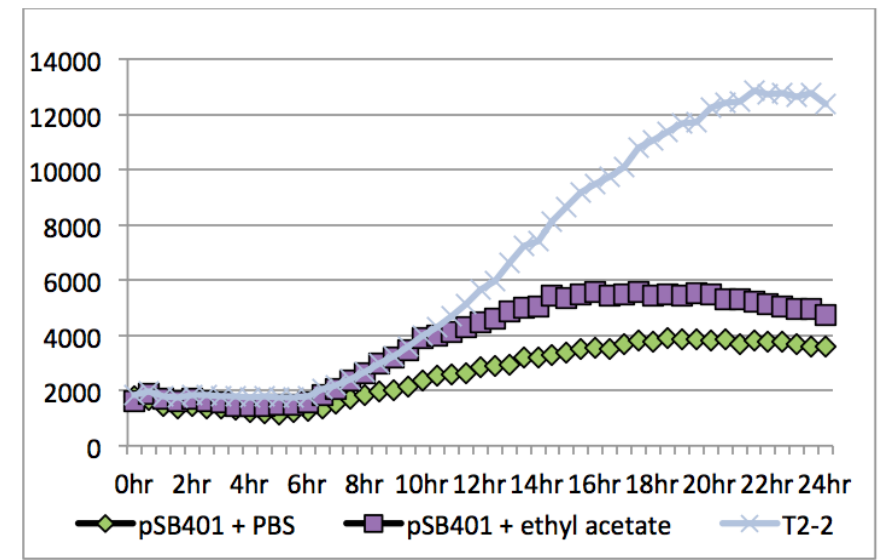
Figure 3. Measurement of bioluminescence. Bioluminescence and OD were measured throughout growth for 24 h at 37 °C in the presence of PBS buffer (diamond) and ethyl acetate (square) as negative controls, and AHL extract from strain T2-2 ( P. putida ) (asterisk). Each point was the average of data obtained from three experiments. Horizontal axis: time (hr, hour), vertical axis (RLU/OD where RLU: relative light unit, OD: 600 nm optical density at 600